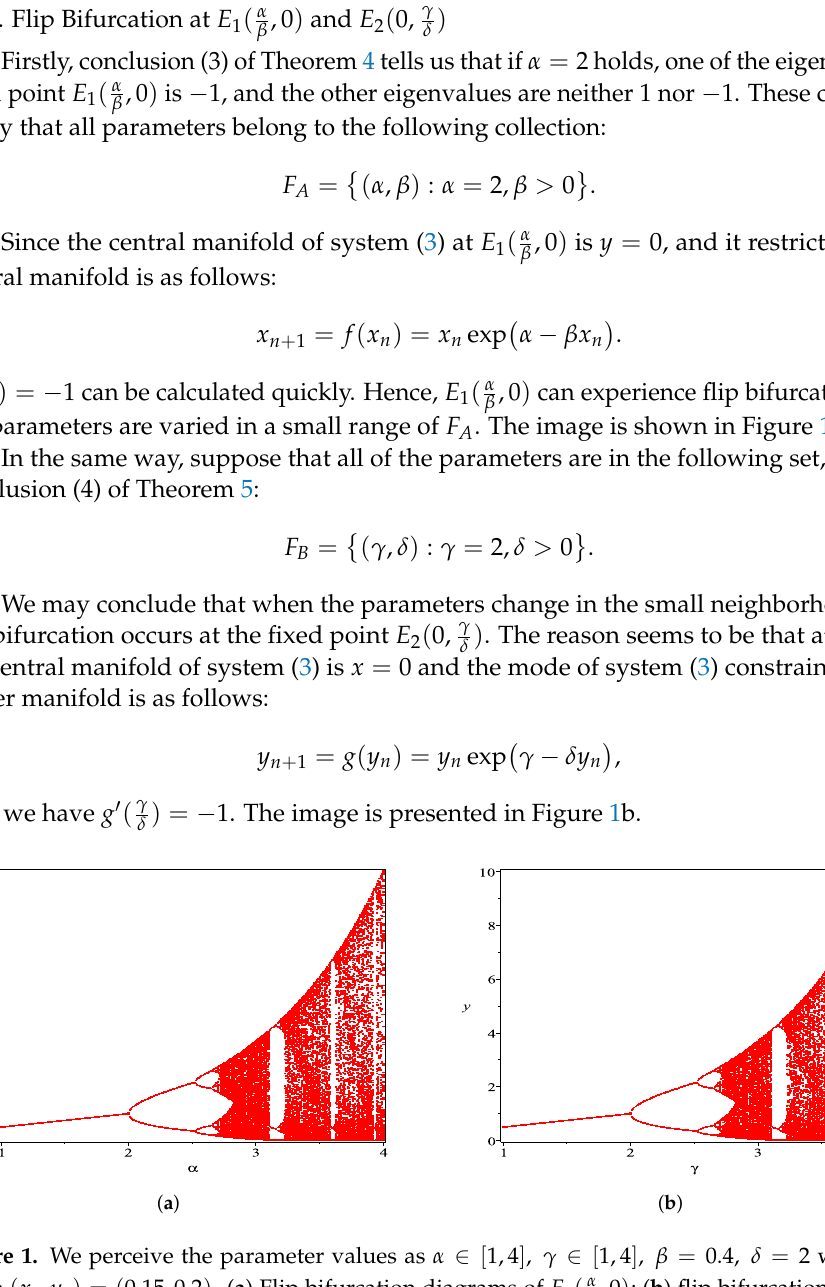
,0 ) ; ( b ) flip bifurcation diagrams β